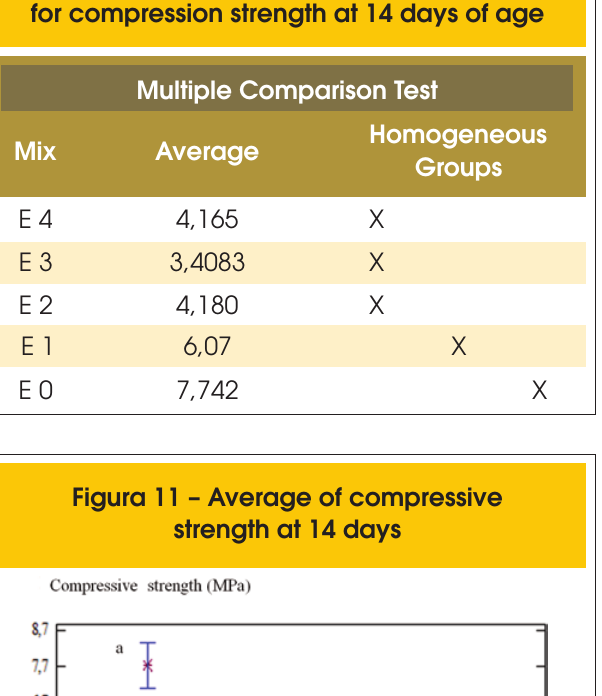
Table 4 – Results of Multiple Comparison Test for compression strength at 28 days of age